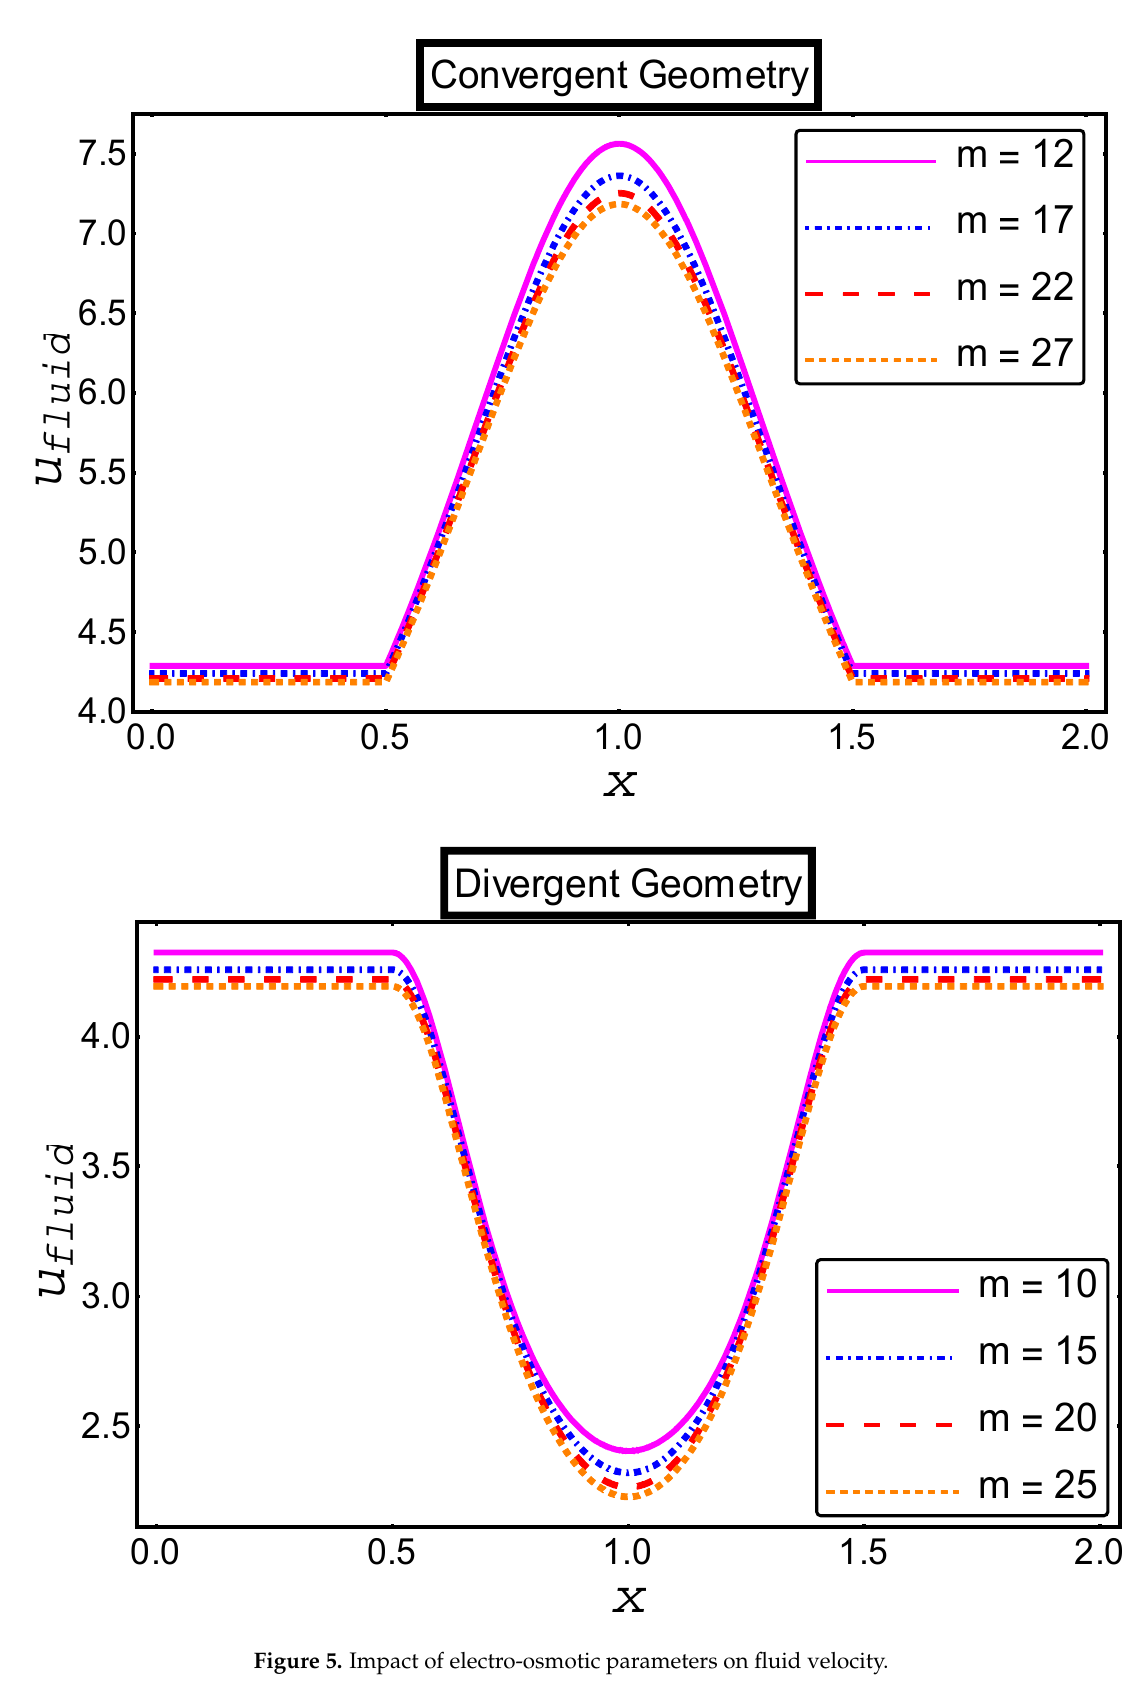
Figure 5. Impact of electro-osmotic parameters on fl uid velocity.